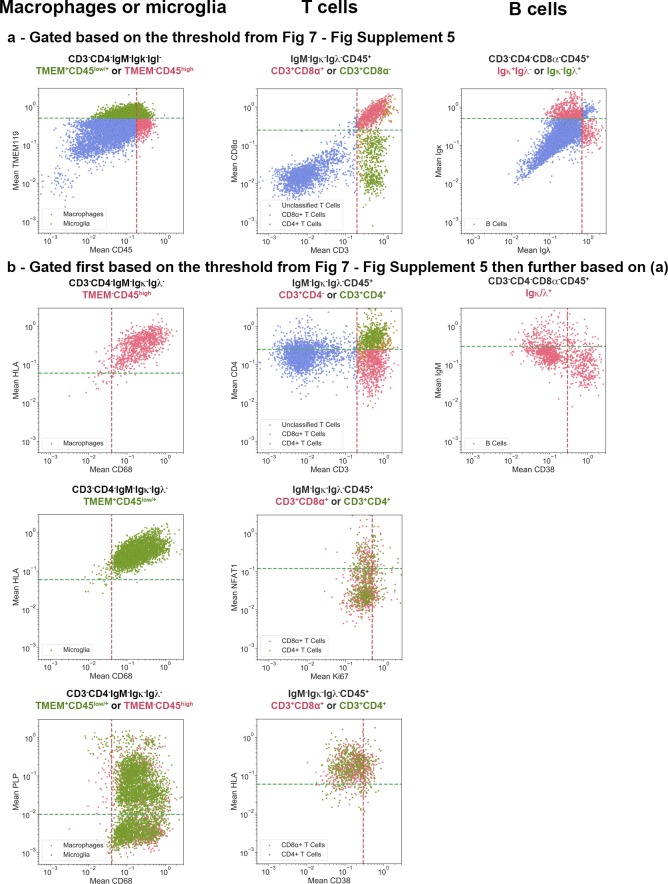
Gating strategy used for the generation of heat maps.Using the quadrants that capture the appropriate positivity range of each cell phenotype shown in Figure 7—figure supplement 5, cells were subjected to the positive and negative gating strategies as outlined in the Materials and methods for each lineage and indicated in (a). Subsequently, these cells were plotted for the marker combinations listed in Table 2. The frequency of cells in each quadrant are indicated. Note that some CD3+CD45+ T cells could not be classified because they fell outside of the specified gates for either of the two markers – CD8+ cells that were not simultaneously CD4-, or CD4+ cells that were not simultaneously CD8-. This is due to the dynamic range of these particular markers and thus our inability to get a clean CD4+CD8- or CD4-CD8+ T cell population. Cells that fulfilled the gating criteria specified above each image, but which did not fulfill the requirements for classification as Macrophages, Microglia, B cells or T cells, are shown in blue.